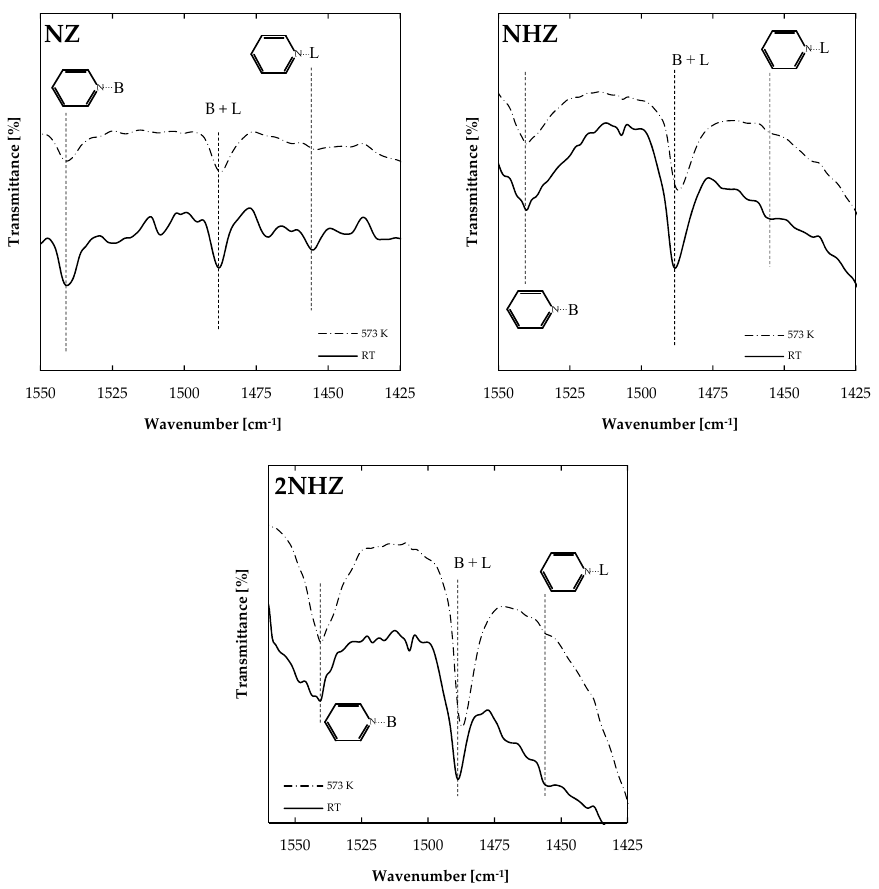
Figure 1. Diffuse reflectance infrared Fourier transform (DRIFT) spectrum of adsorbed pyridine on natural and modified zeolite.